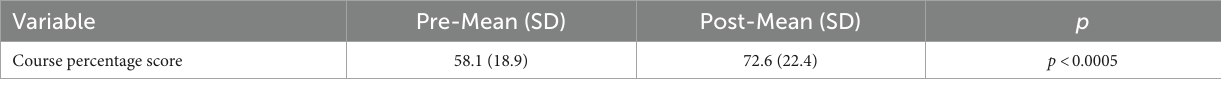
TABLE 3 T-test analysis for the statistical significance.